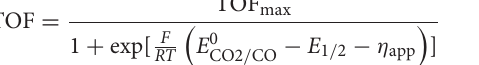
is essential for comparing the effects of pendent functional groups on the activity of